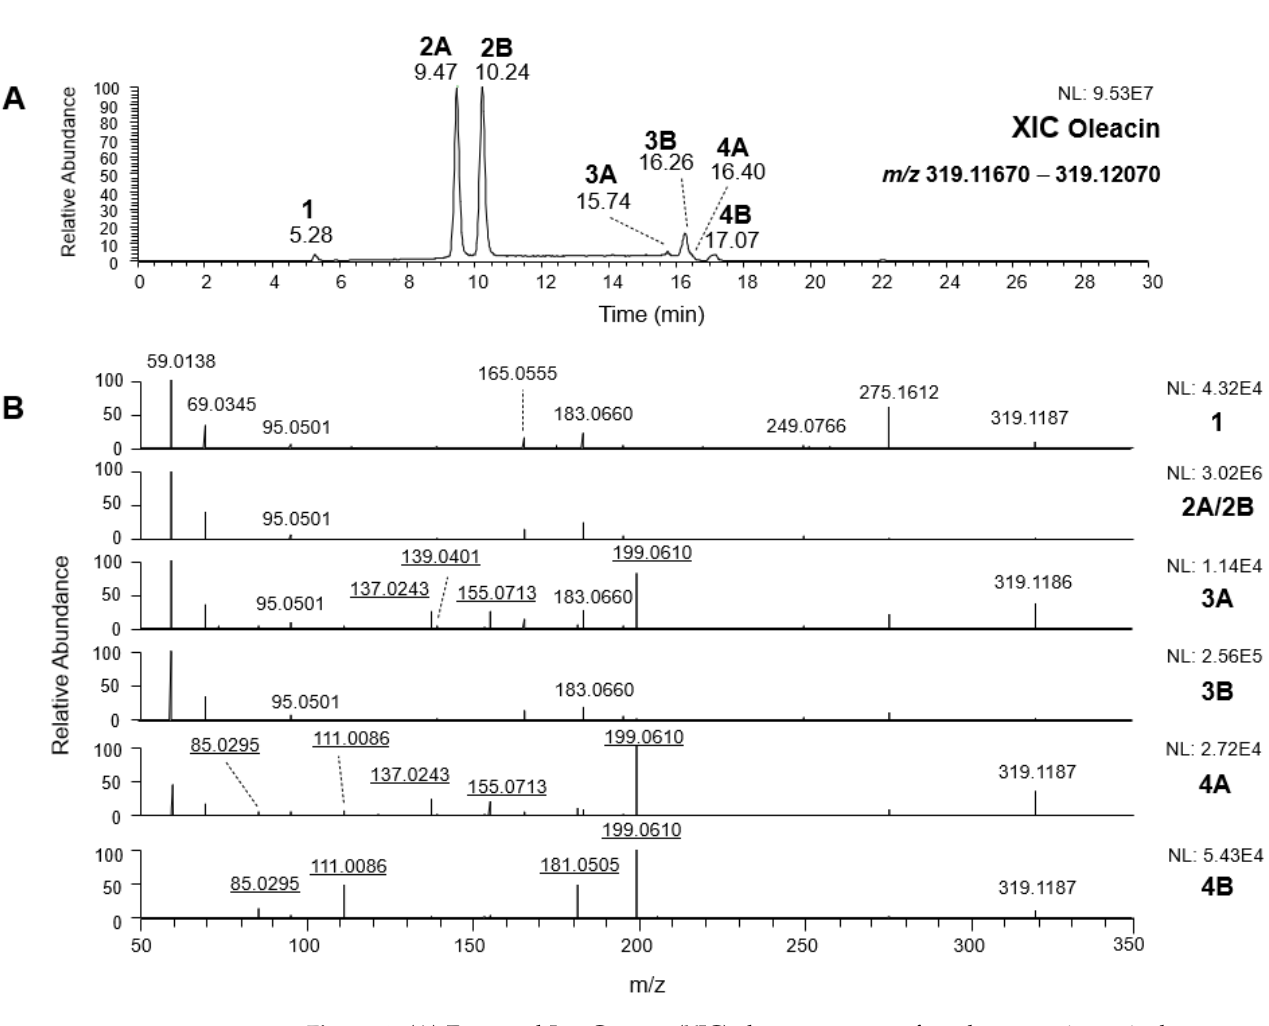
Figure 3. ( A ) Extracted Ion Current (XIC) chromatogram referred to monoisotopic deprotonated OLEA ([M ‐ H] − , m / z 319.1187) obtained after the RPLC ‐ ESI( ‐ ) ‐ FTMS analysis of an EVOO extract. ( B ) HCD ‐ FTMS/MS spectra averaged under the main chromatographic peaks detected in the XIC trace. See Figures 4 and S1, S2 and S3 (Supplementary Material) for structures hypothesized for each product ion detected. Underlined m / z ratios are referred to product ions related to oleocanthalic acid isoforms. To avoid redundancy, m / z labels for product ions identical in different spectra were not reported in all spectra. NL = Normalization Level